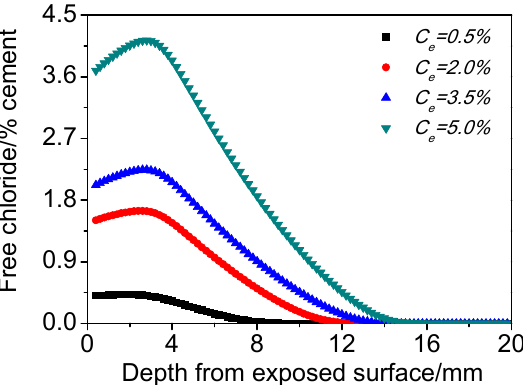
Figure 9. Influence of C e on the chloride distribution of concrete subjected to cyclic wetting and drying conditions.